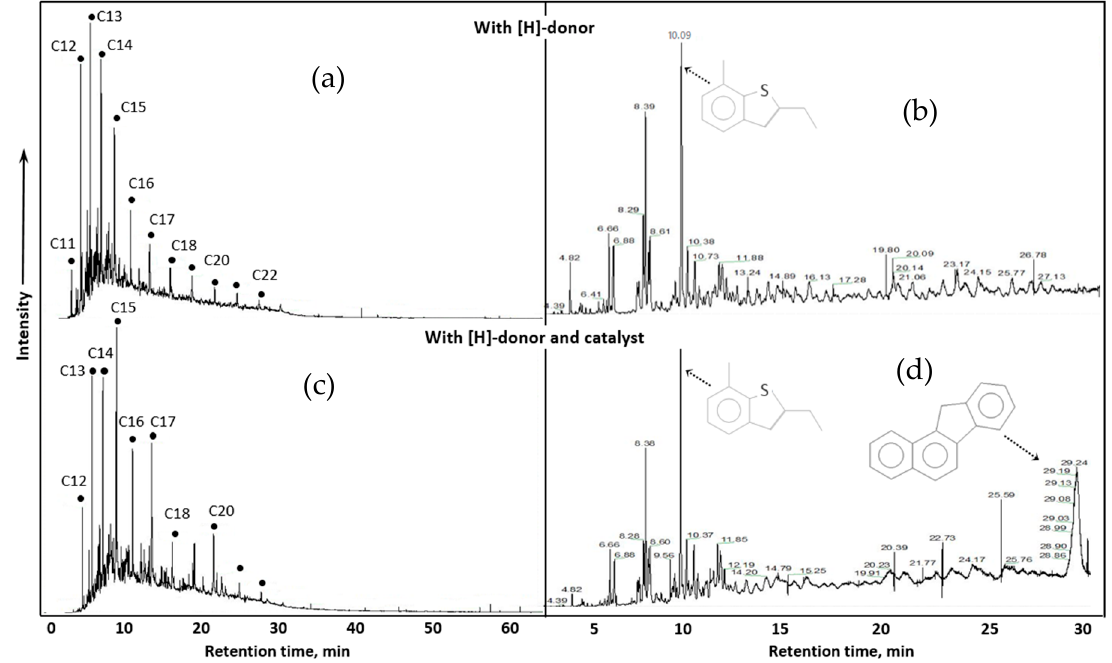
Figure 7. Total ion chromatograms of saturated hydrocarbons ( a , c ) and aromatic hydrocarbons ( b , d ) after aquathermolysis in the presence ( c , d ) and absence ( a , b ) of nickel-based catalyst for 96